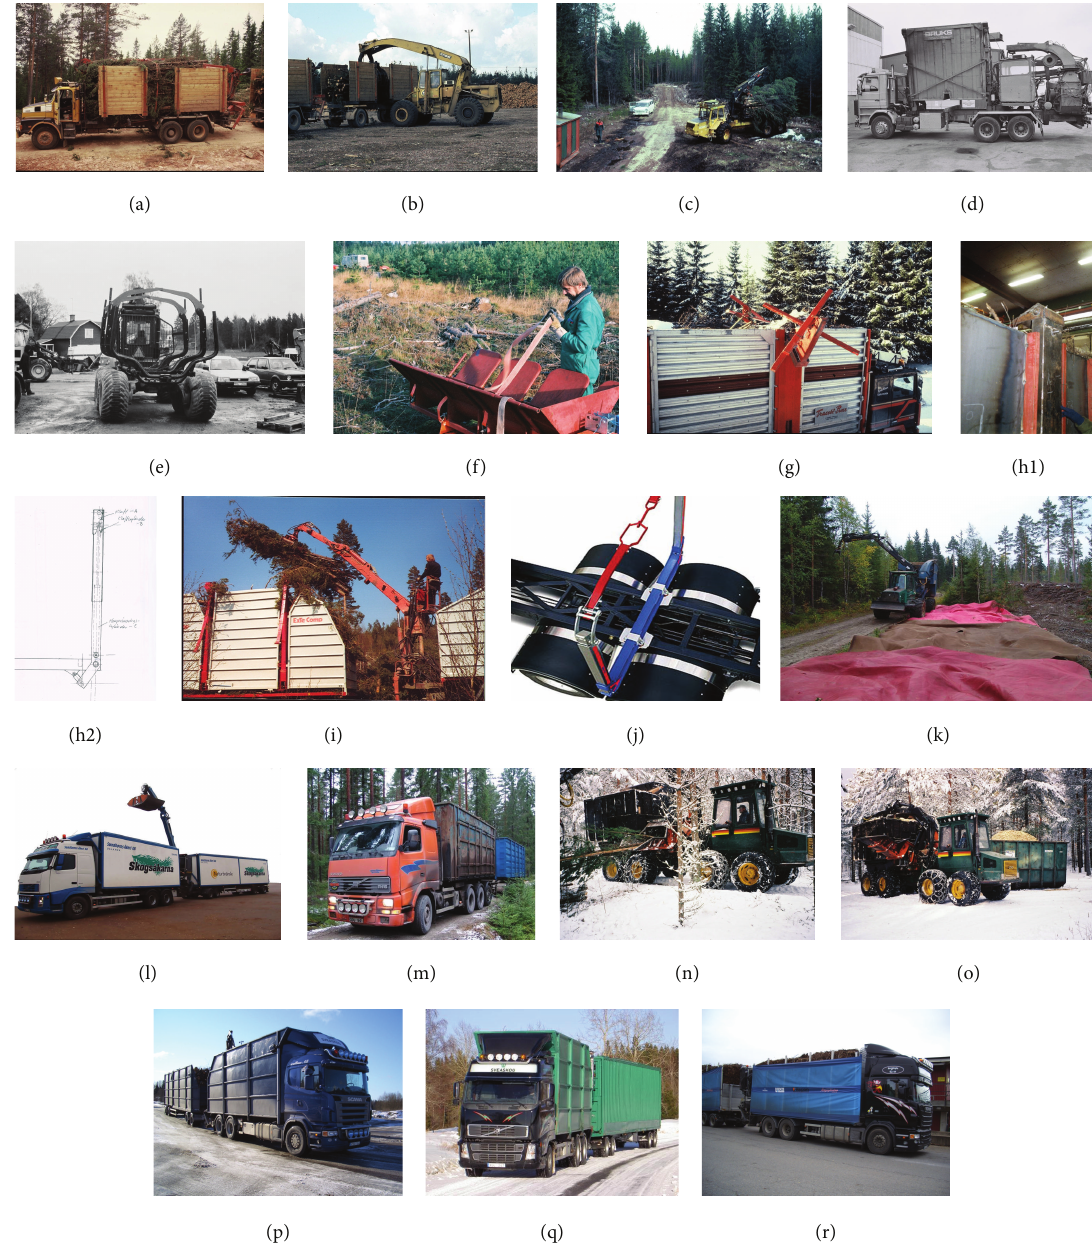
Figure 1: (a) Test truck for transport of tree sections with sides and floor being covered with planks. (b) Unloading tree sections at terminal with Pettibone Carry Lift. (c) Forwarding tree sections. (d) Truck with an integrated wood chipper for chipping at road side. (e) A forwarder with articulated stakes for compression. (f) Compressing unit for bundles in private forestry. (g) The Tracobi Press. (h1) The Hydrov˚ag truck for compressing and transporting tree sections. (h2) Principles for compressing with the Hydrov˚ag truck (early drawing, A = flap, B = cylinder for manoeuvring the flap, C = cylinder for compressing). (i) The ExTe Comp tested for compressing and transport of tree sections. (j) The ExTe Comp system (Com 90) used for safety and ergonomic reasons when transporting round wood. (k): Tarpaulins on the ground for fuel chips. (l) Self-loading truck with a bucket for transport of wood chips from road side/landing. (m) Traditional container system (here with 2 bins). (n) Chipping in the stand. (o) Transport to landing and then filling transport container with fuel chips. (p) The specialized vehicle 1 observed in the time study. (q) The specialized vehicle 2 observed in the time study. (r) Specialized vehicle for bundled loose residues observed in the time